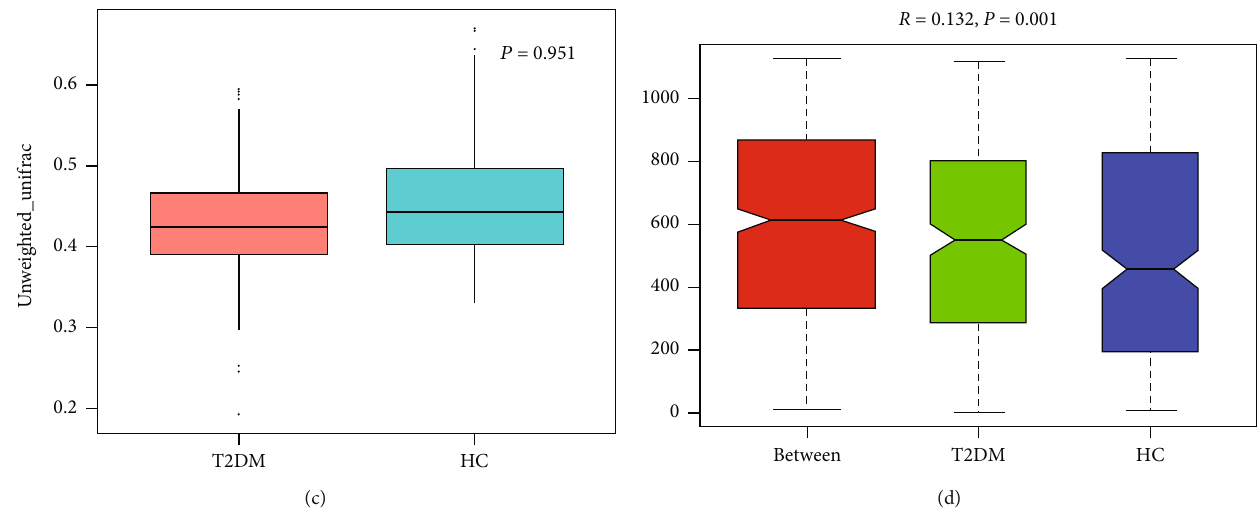
Figure 1: Multisample comparison analysis (beta diversity indices) between the type 2 diabetes mellitus (T2DM) group and healthy control (HC) individuals. PCoA based on (a) unweighted_unifrac, (b) NMDS Plot, and (c) unweighted beta diversity compared the microbial community of the type 2 diabetes group ( n = 24 ) with healthy individuals ( n = 24 ). (d) Anosim analysis describes the variation between and within the groups. R value is between -1 and 1. R value greater than zero indicates a signi fi cant di ff erence between groups, while less than zero indicates that the di ff erence within the group is greater than between the groups. The reliability of the statistical analysis is represented by probability value ( P < 0 : 05 indicates that the statistic is signi fi cant). A: label of T2DM samples; B: label of HC samples; n :